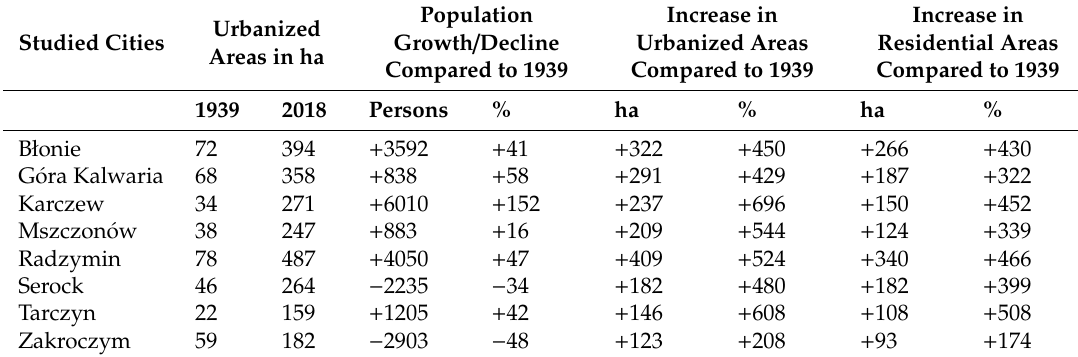
Table 4. Increase in building land and population compared to 1939.